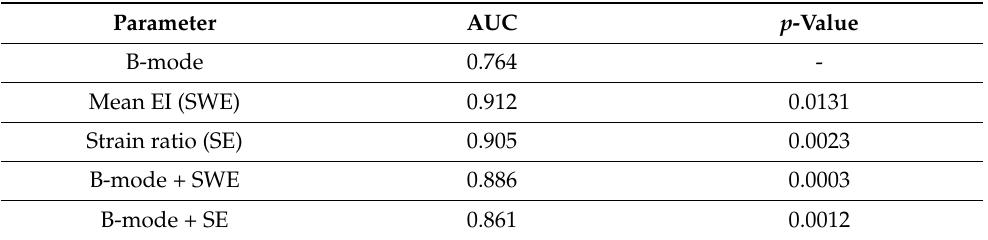
Figure 8. The receiver operating characteristic curve for the diagnostic performance of thyroid cancer through shear-wave elastography (SWE) with the parameter Mean elasticity index (SWE Mean), strain elastography (SE) with the parameter strain ratio, conventional US (2B), 2B combined with SWE and 2B combined with SE. Table 7. The performance of strain and 2D shear-wave parameters alone and as additional evaluation for conventional ultrasound (2B), being compared to 2B evaluation alone.